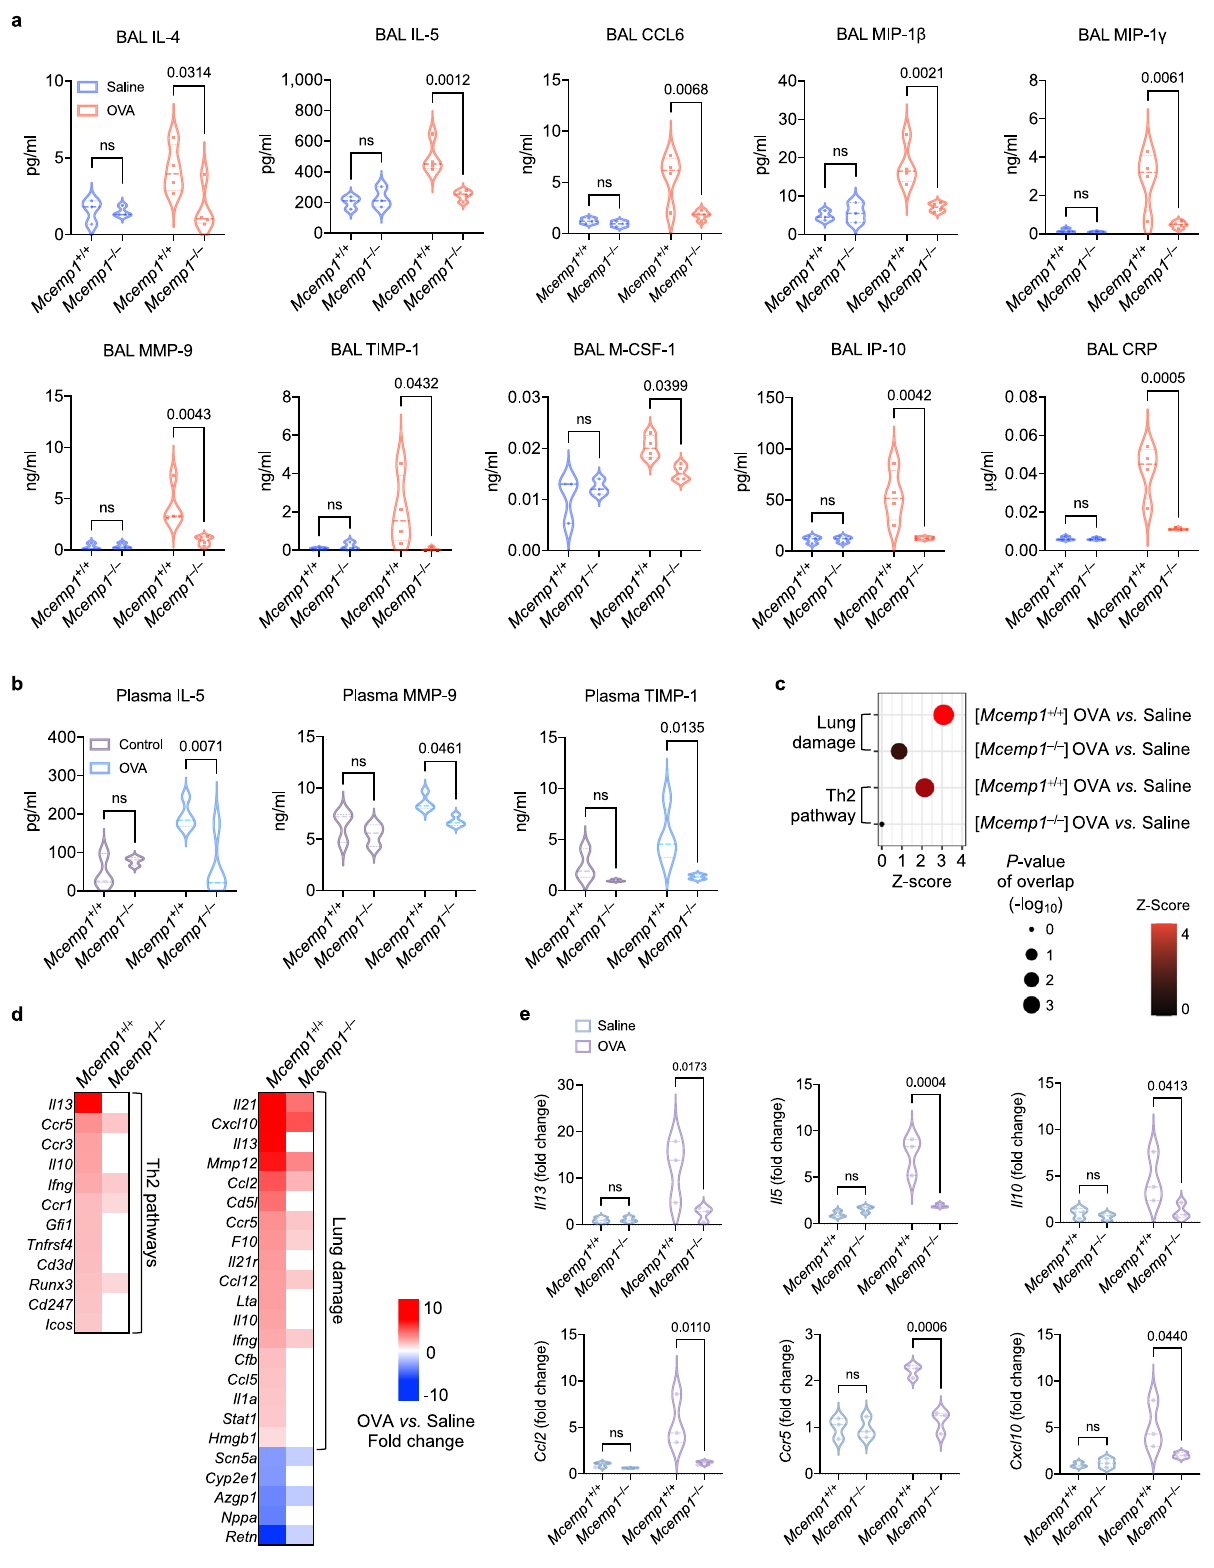
Flag antibody stimulation Cells (5×10 6 ) were washed once with serum free DMEM, resuspended in 25 μ l serum free DMEM, pre-incubated for 10min at 37°C. 25 μ l of cells were incubated with 25 μ l of monoclonal mouse anti-Flag anti- body (1 μ g) for 1~5min at 37 °C. Cells were centrifuged at 1000 × g for 1 min at 4 °C and rapidly frozen by a dry ice/ethanol or liquid nitrogen.